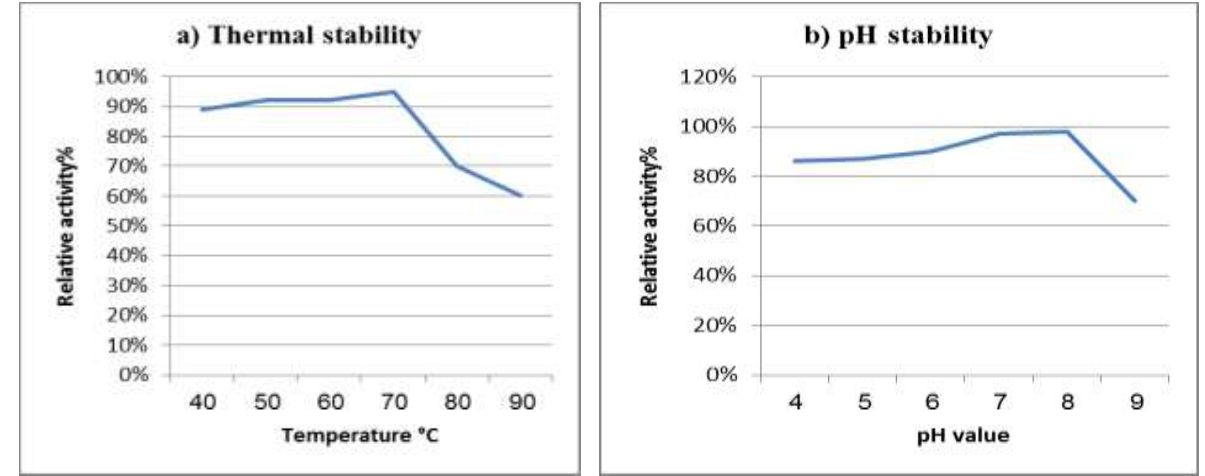
Figure 3: Effect of a) Temperature and b) pH stability on